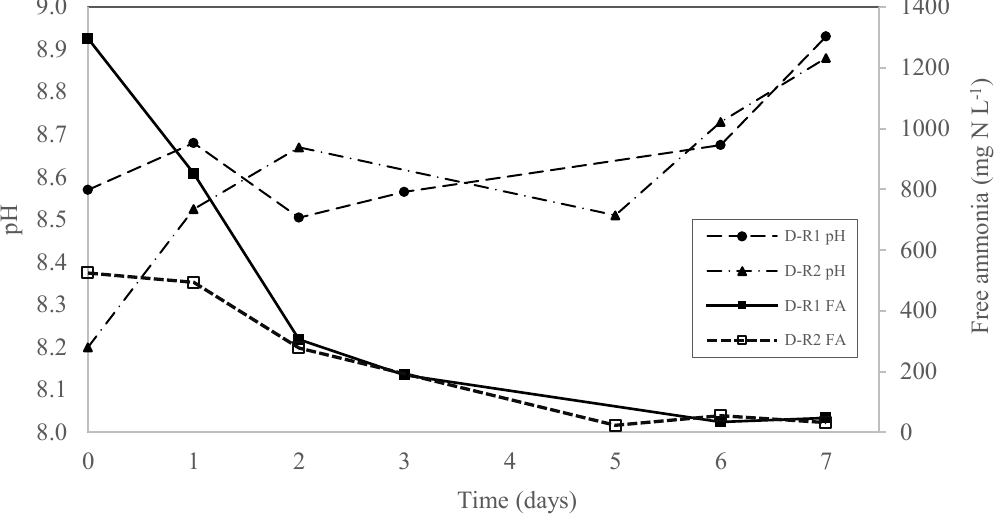
Figure 7. The evolution of the pH and the free ammonia (FA) for D-R1 and D-R2 during the N recovery experiments.